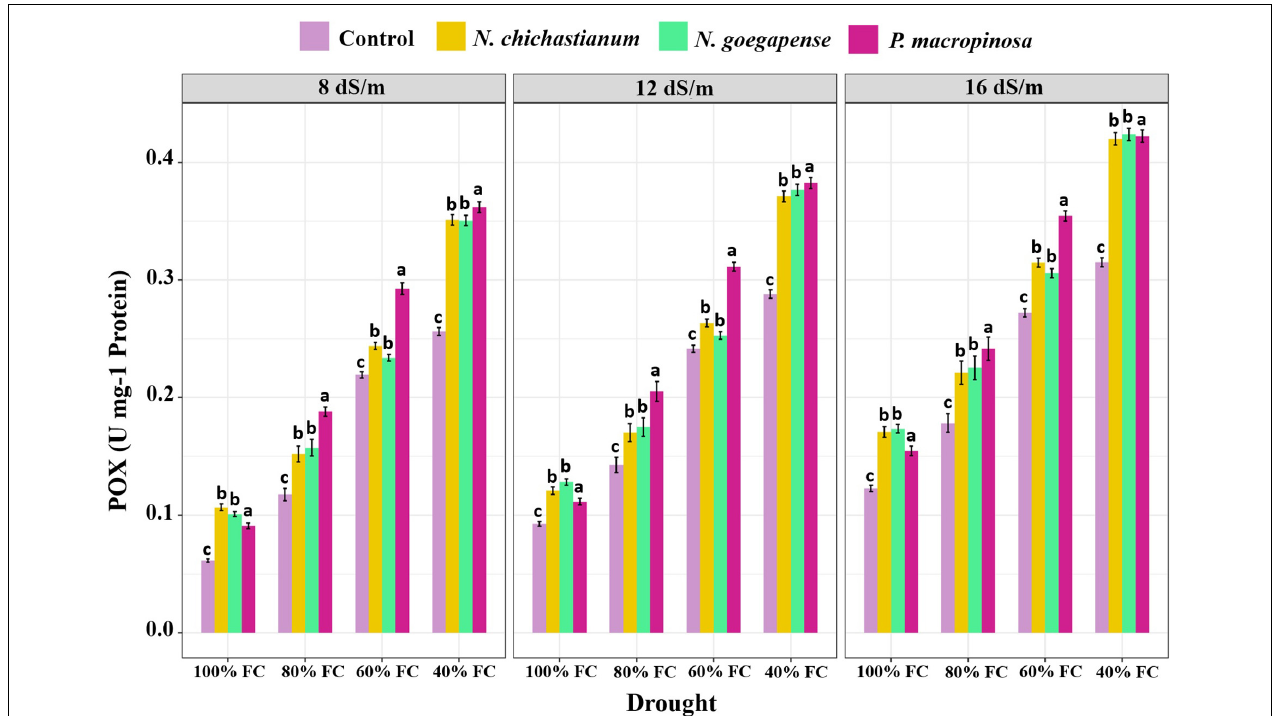
FIGURE 5 | The effects of halotolerant endophytic fungi species on POX activity of barley plants under salinity and drought stress. Different levels of drought stress and different fungal treatment are shown on the horizontal axis and colorful bars, respectively. Various letters on the top of bars display significant differences between mean values of different fungal treatments under the different levels of salinity and drought stress at p ≤